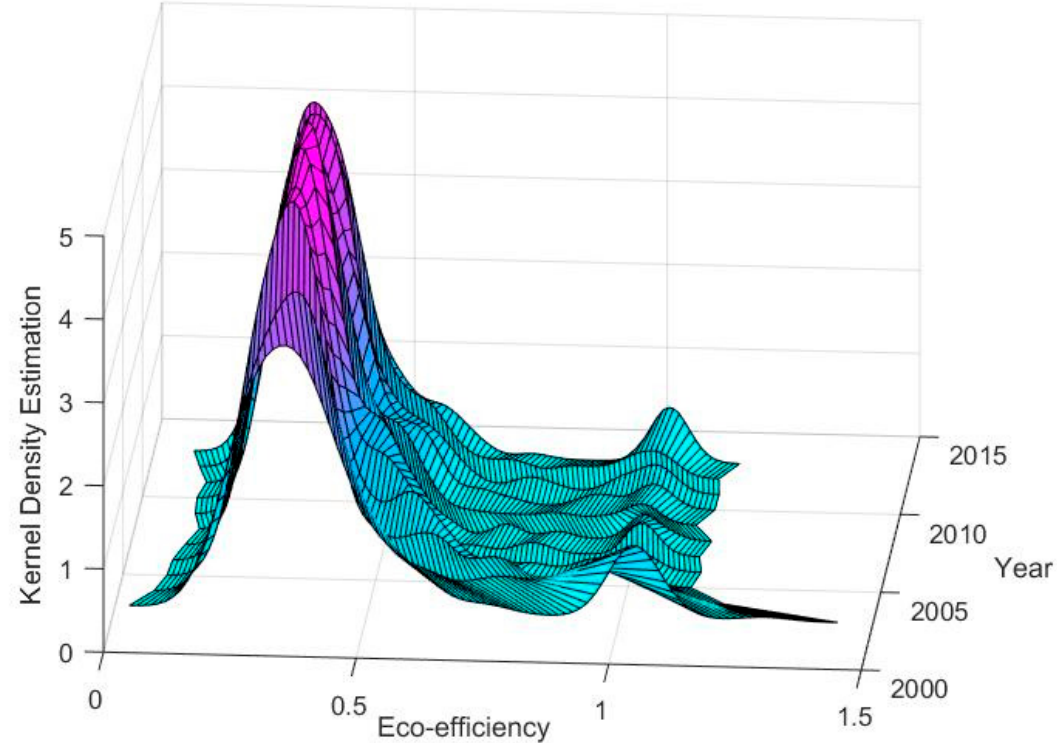
Figure 1. Dynamic evolution of urban eco-efficiency (2003–2013).